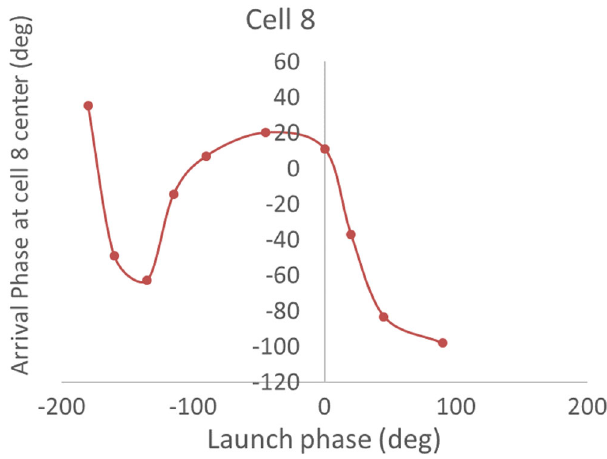
FIG. 6. Arrival phase at the center of the last cell as a function of the electron launch phase from the cathode.